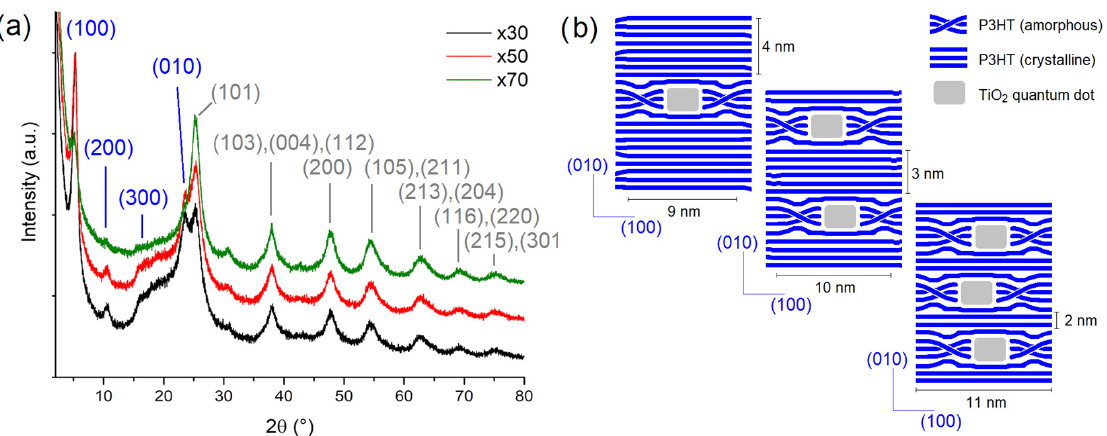
Figure 1. ( a ) X-ray di ff raction pa tt erns and ( b ) schematization of most relevant structural features for ×30, ×50 and ×70 nanocomposites.